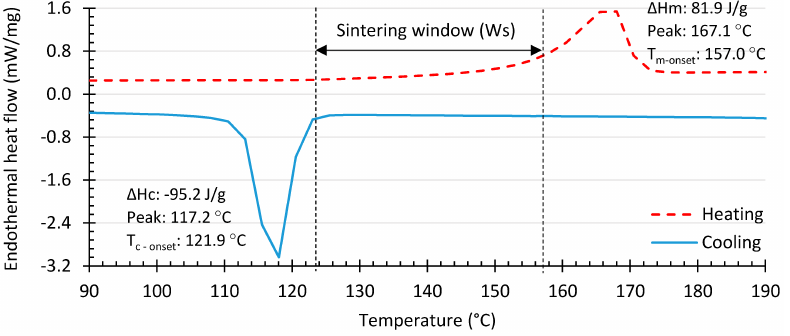
Figure 5. Differential scanning calorimetry thermograph of neat iPP (Advance3d materials) at a heating and cooling rate of 10 ◦ C min − 1 . The sintering window is 35.1 ◦ C, and the overall degree of crystallinity is 39.58%. Reproduced with permission [91], Copyright 2018,